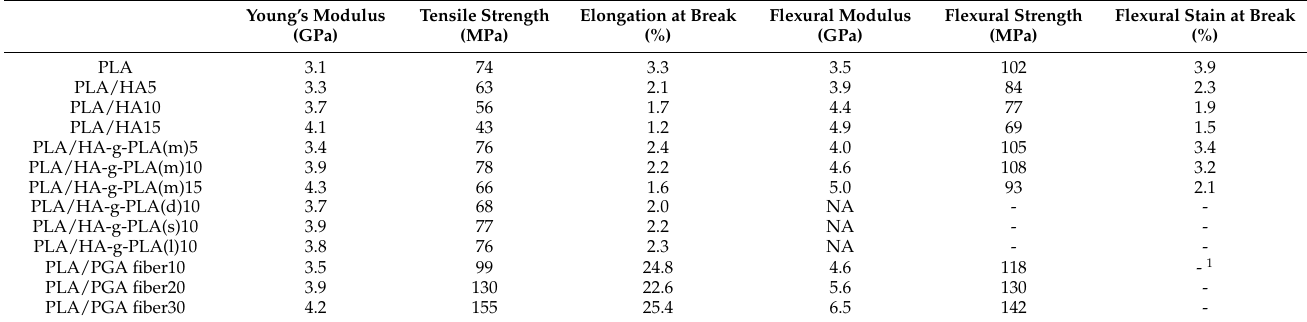
Table 2. Mechanical properties of PLA and its